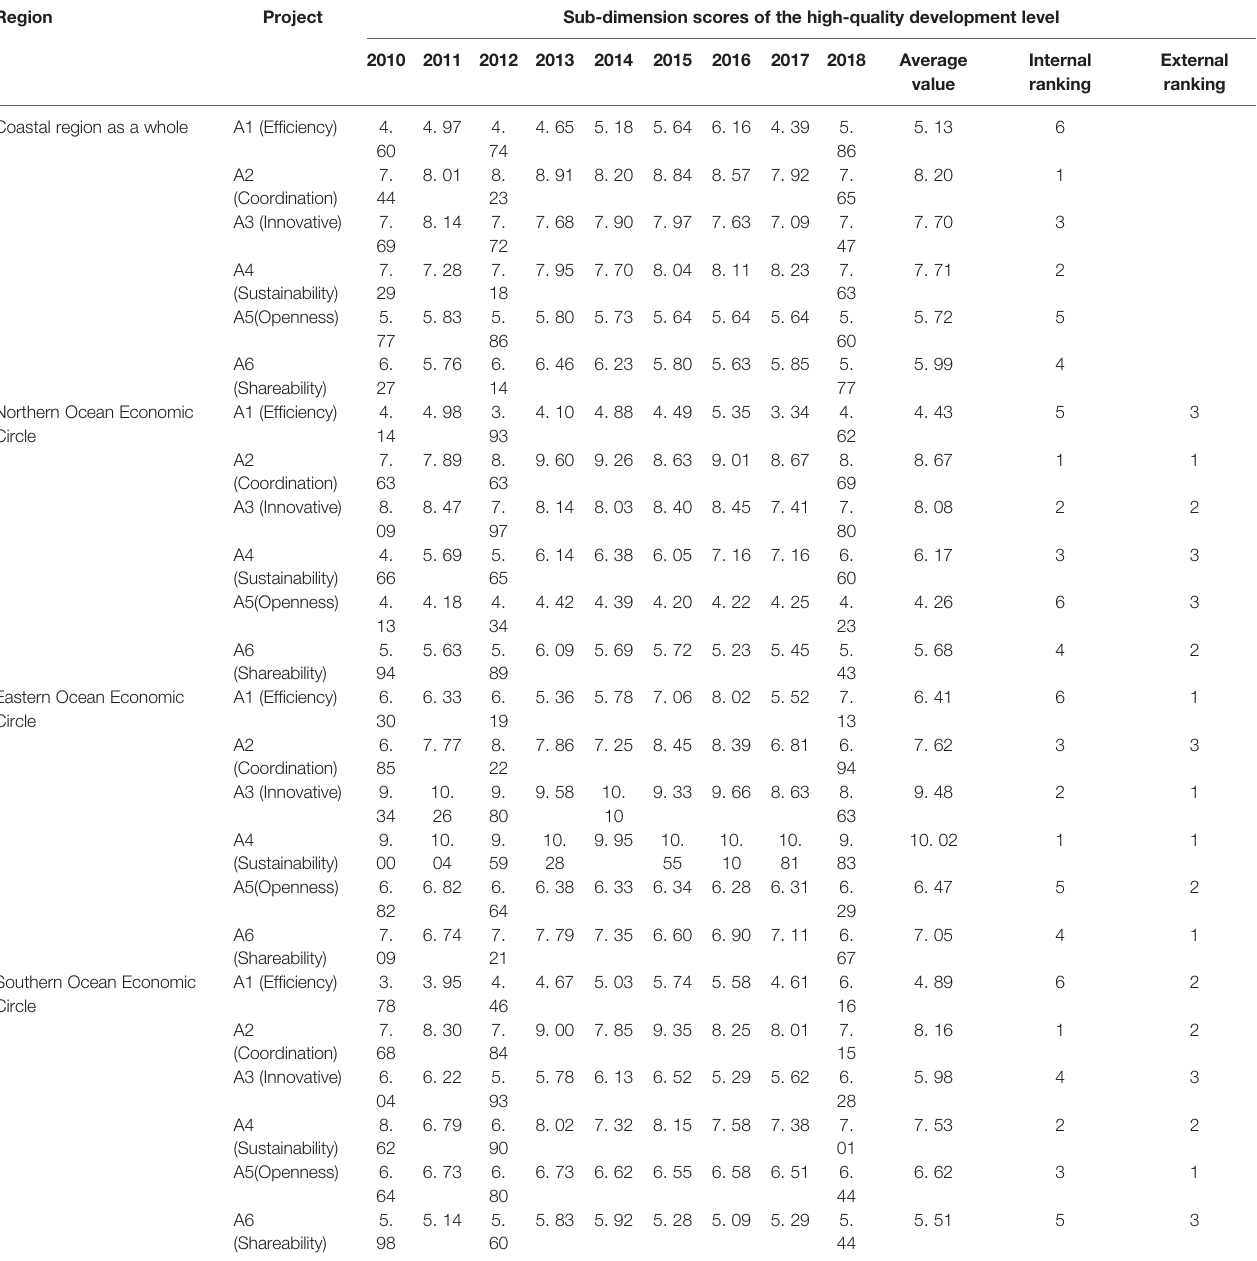
TABLE 3 | Sub-dimension scores of the high-quality development level of marine economy in China ’ s coastal regions and the three ocean economic circles. Region